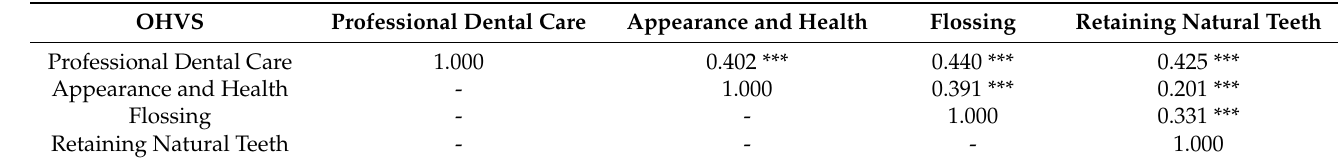
Table 7. Correlation between OHVS subscales